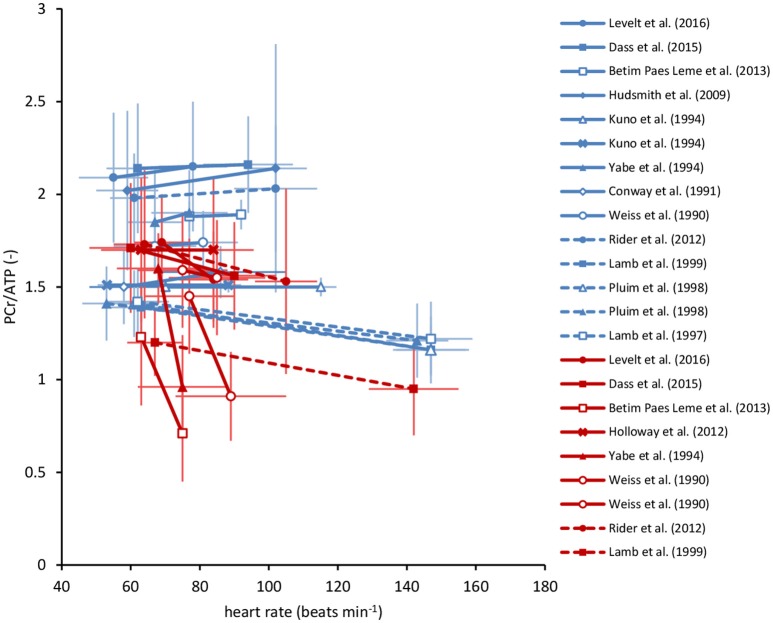
Overview of myocardial PCr/ATP ratios in human cardiac 31P-MRS stress testing reported in the literature. These studies involved measurements in healthy volunteers (blue) and various patient populations (red), at rest and during exercise (solid lines), or pharmacologically induced stress (dashed lines). Studies that documented both heart rate as well as the myocardial PCr/ATP ratio at rest and at increased cardiac work rates are included. Error bars represent SD. Note the large variability in the reported PCr/ATP ratios, both within as well as between studies. See literature for individual study details (Weiss et al., 1990; Conway et al., 1991; Kuno et al., 1994; Yabe et al., 1994; Lamb et al., 1997, 1999; Pluim et al., 1998; Hudsmith et al., 2009; Holloway et al., 2012; Rider et al., 2012; Betim Paes Leme et al., 2013; Dass et al., 2015; Levelt et al., 2016). ATP, adenosine triphosphate; PCr, phosphocreatine.